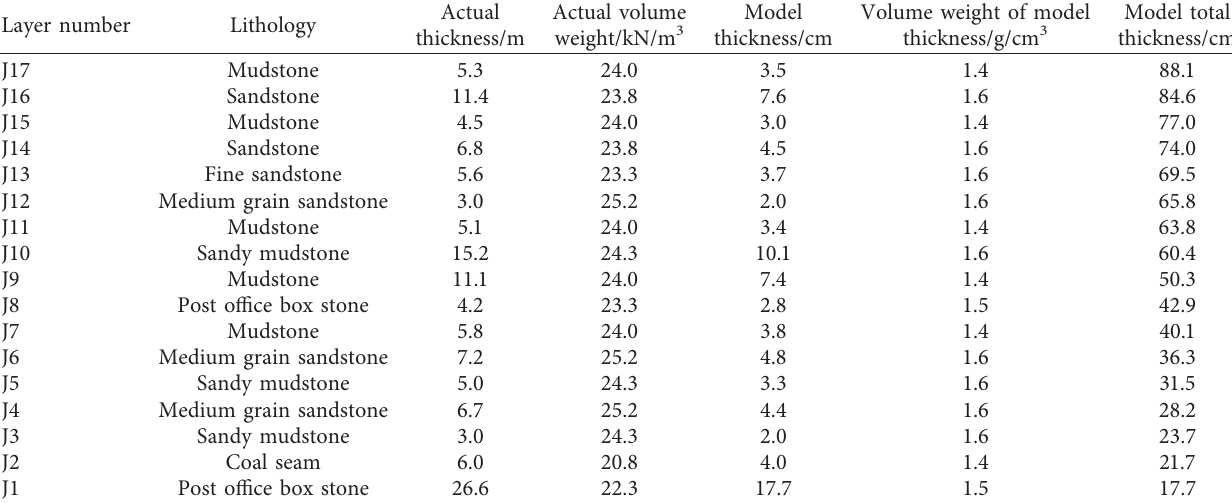
Table 3: Prototype and comparison of similar model